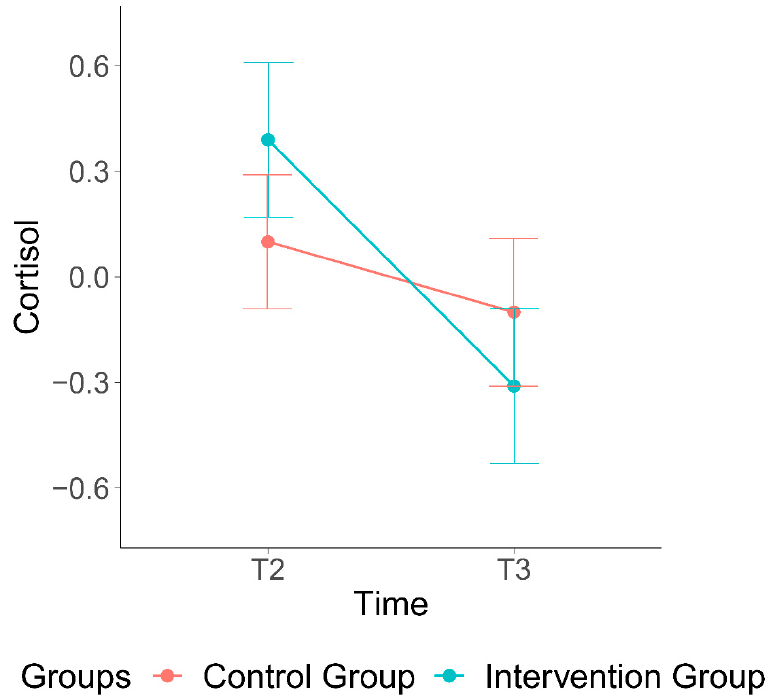
Figure 3. Effect of the VIPP-Intervention on hair cortisol levels.